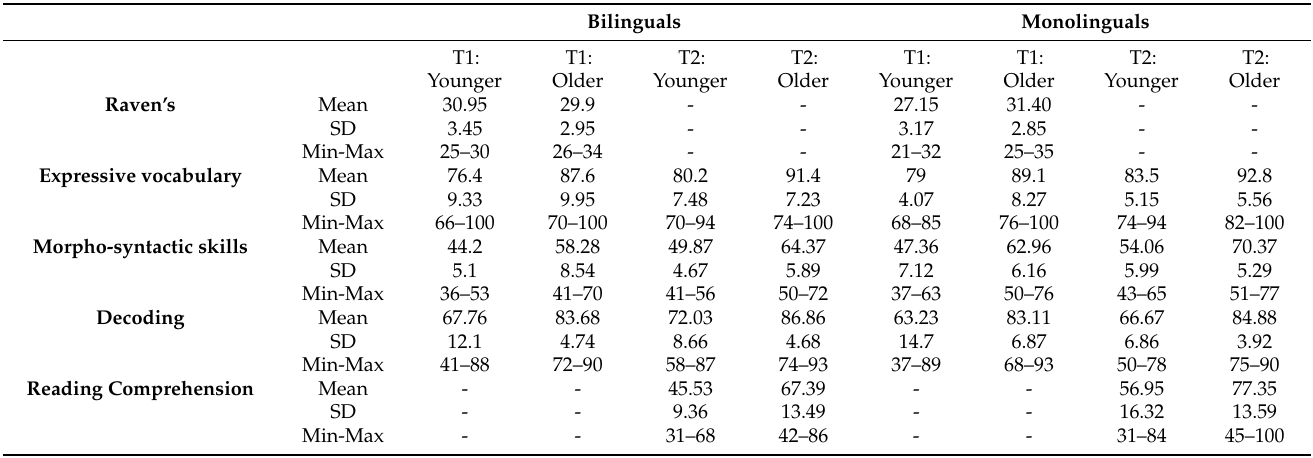
Table 2. Descriptive statistics of the younger and older bilinguals and their monolingual peers’ performance on the Raven’s Coloured Progressive Matrices and the English expressive vocabulary, morpho-syntax and decoding (real-words, pseudo-word) and reading comprehension tasks (percentage correct) across the four years of primary school in the U.K. Bilinguals